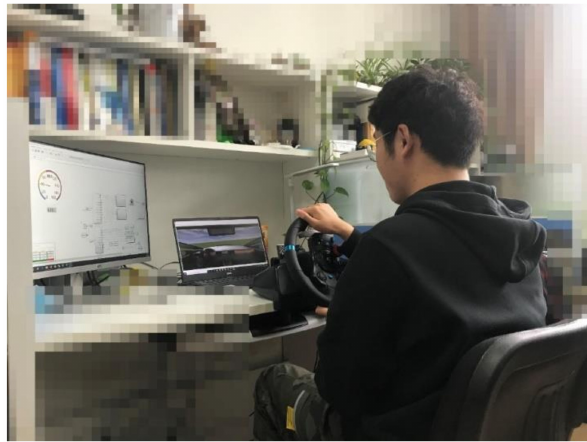
Figure 4. The drivers’ personalized data collection